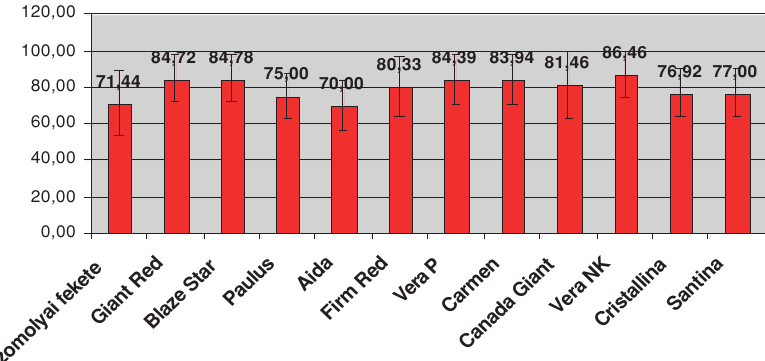
Figure 5. Evaluation of mid season ripening sweet cherry varieties according to the general